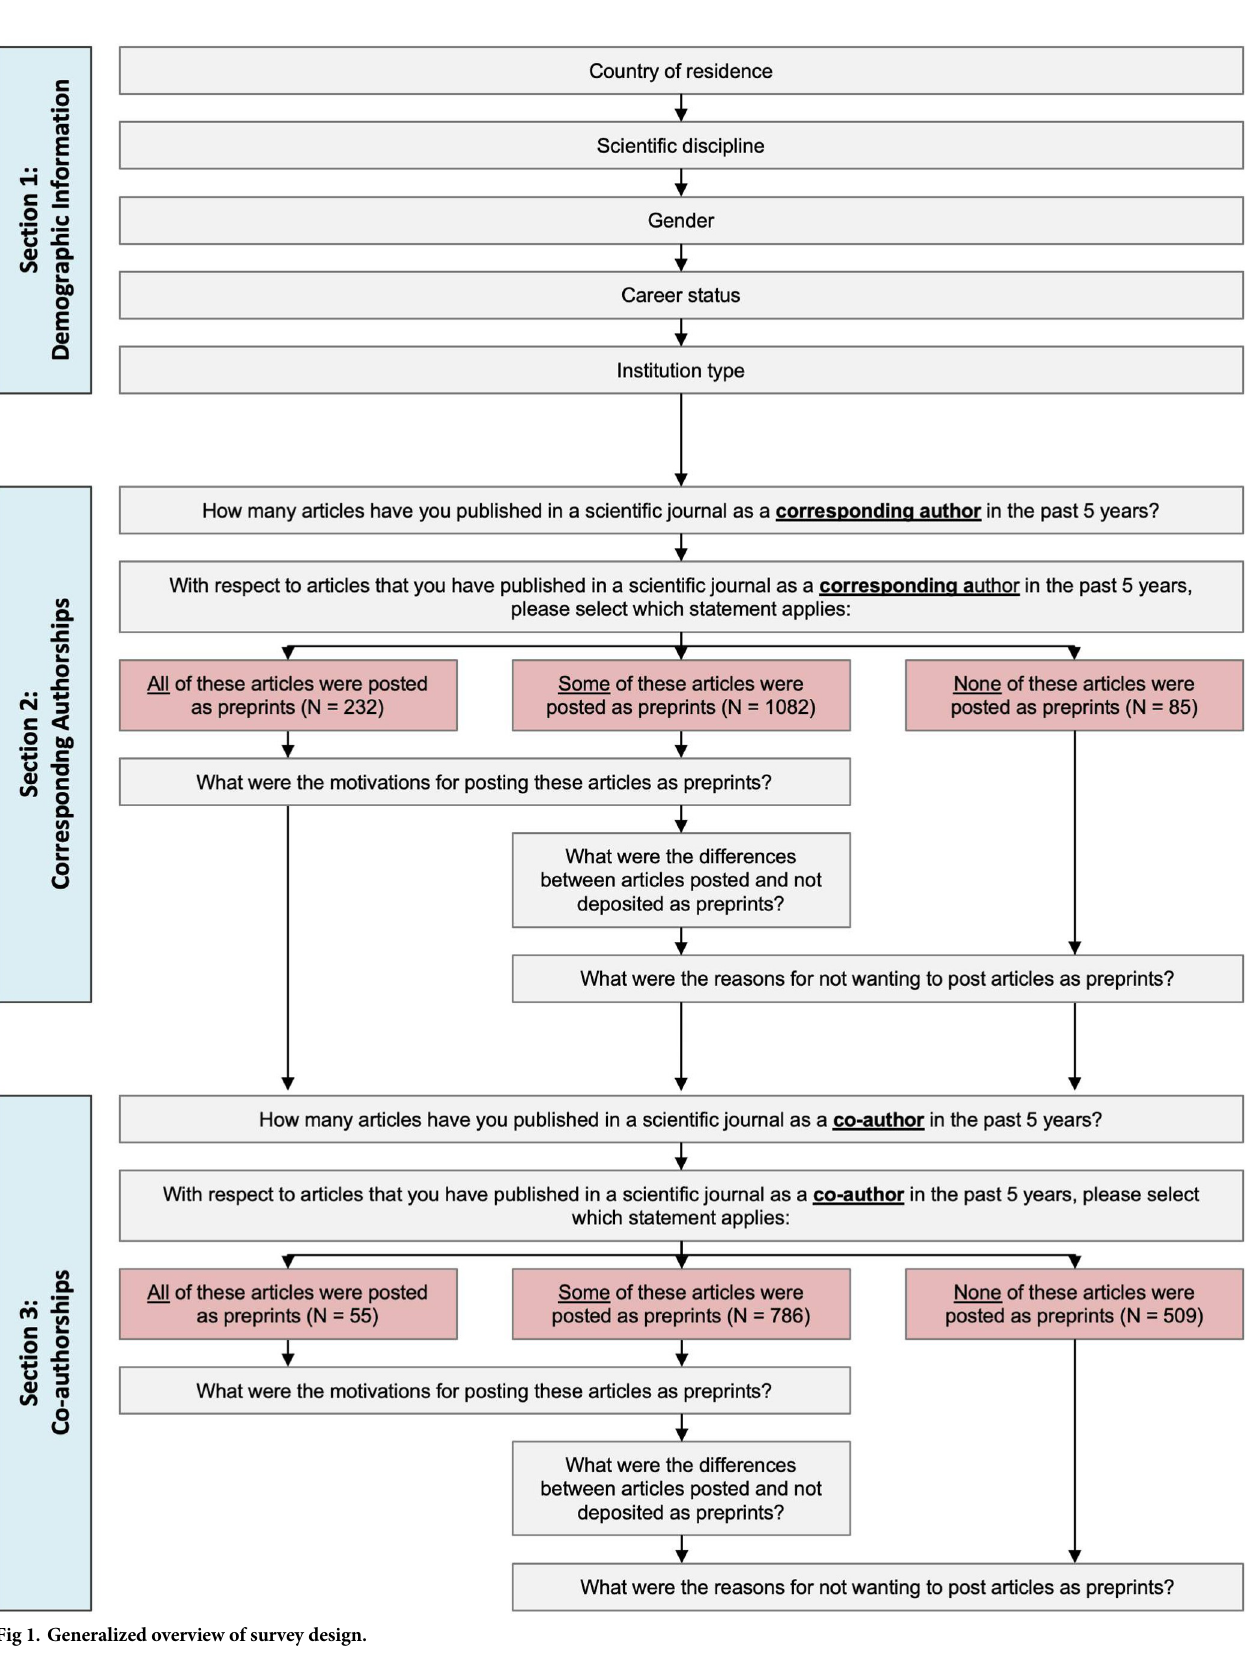
Fig 1. Generalized overview of survey design.